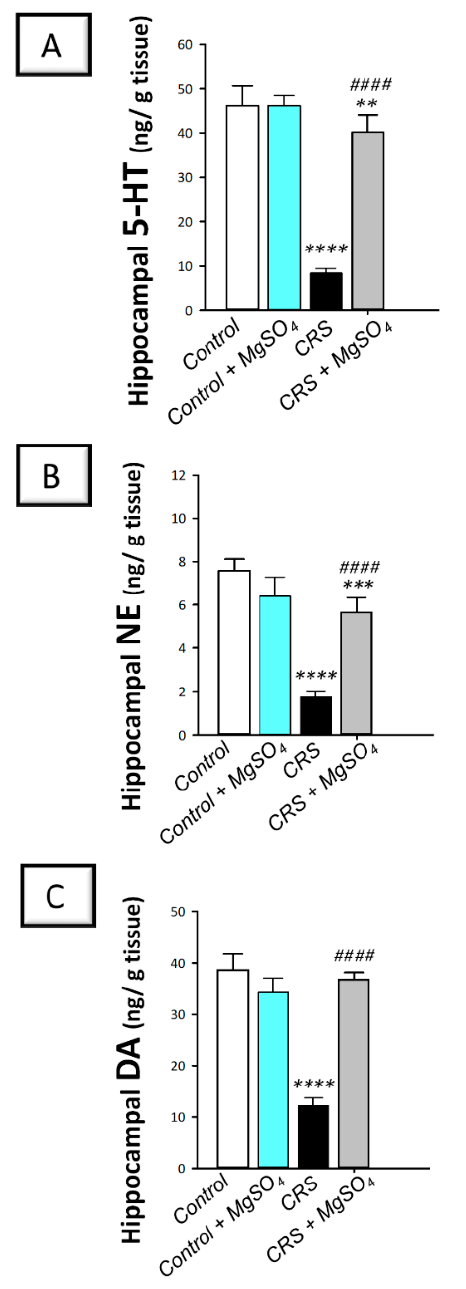
Figure 5. Effect of magnesium sulfate on monoamine neurotransmitter levels in the hippocampi of rats exposed to chronic restraint stress (CRS). Administration of magnesium sulfate counteracted the depletion of serotonin [F (3, 20) = 274.0, p < 0.0001] ( A ), norepinephrine [F (3, 20) = 95.76, p < 0.0001] ( B ), and dopamine [F (3, 20) = 167.7, p < 0.0001] ( C ) in the hippocampi of rats exposed to CRS. Values are expressed as the mean of 6 rats ± standard deviation (S.D.). Statistical analysis was applied using one-way ANOVA followed by Tukey’s post-hoc test. Significant differences versus control animals are denoted by ** p < 0.01, *** p < 0.001, or **** p < 0.001. Significant differences versus CRS group are denoted by # ### p < 0.001. CRS, chronic restraint stress; MgSO 4 , magnesium sulfate.